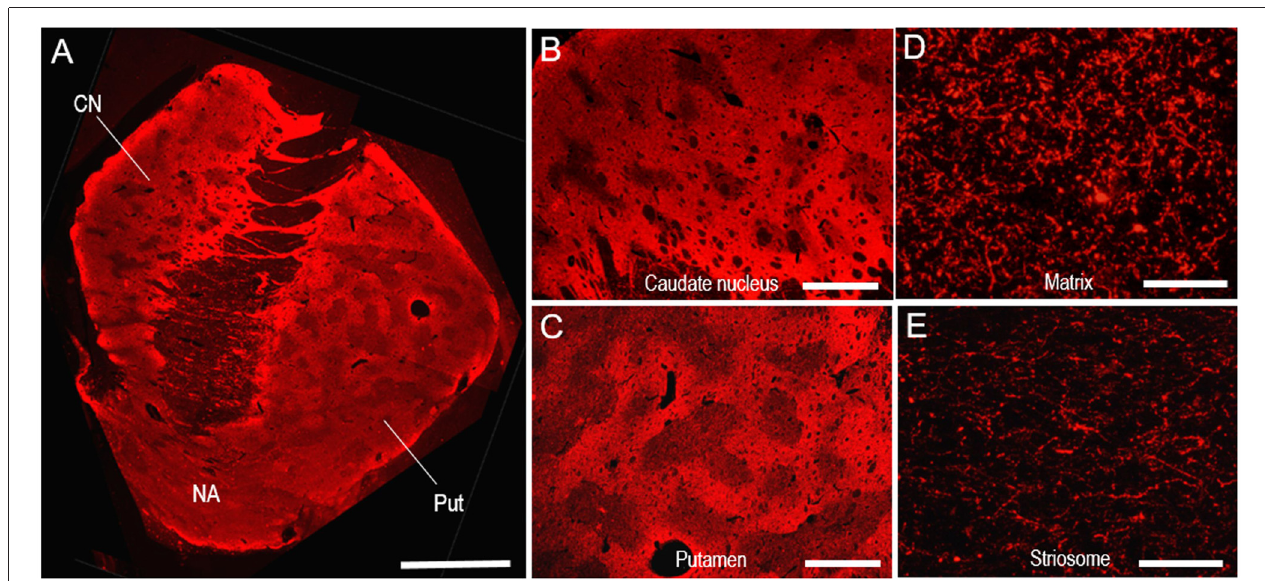
FIGURE 6 | Neostriatal mosaic visualized by TH-immunostaining with Cyanine 3 in human brains. (A) A photomontage of a striatal section stained for TH. (B,C) Photomicrographs of the CN (B) and putamen (C) in the striatum stained for TH. (D,E) Photomicrographs of areas stained for TH in the matrix (D) and striosome (E) of the putamen. Abbreviations: CN, caudate nucleus; Put, putamen; NA, nucleus accumbens. Scale bars: (A) 5 mm, (B,C) 2 mm, (D,E) 50 µ m.